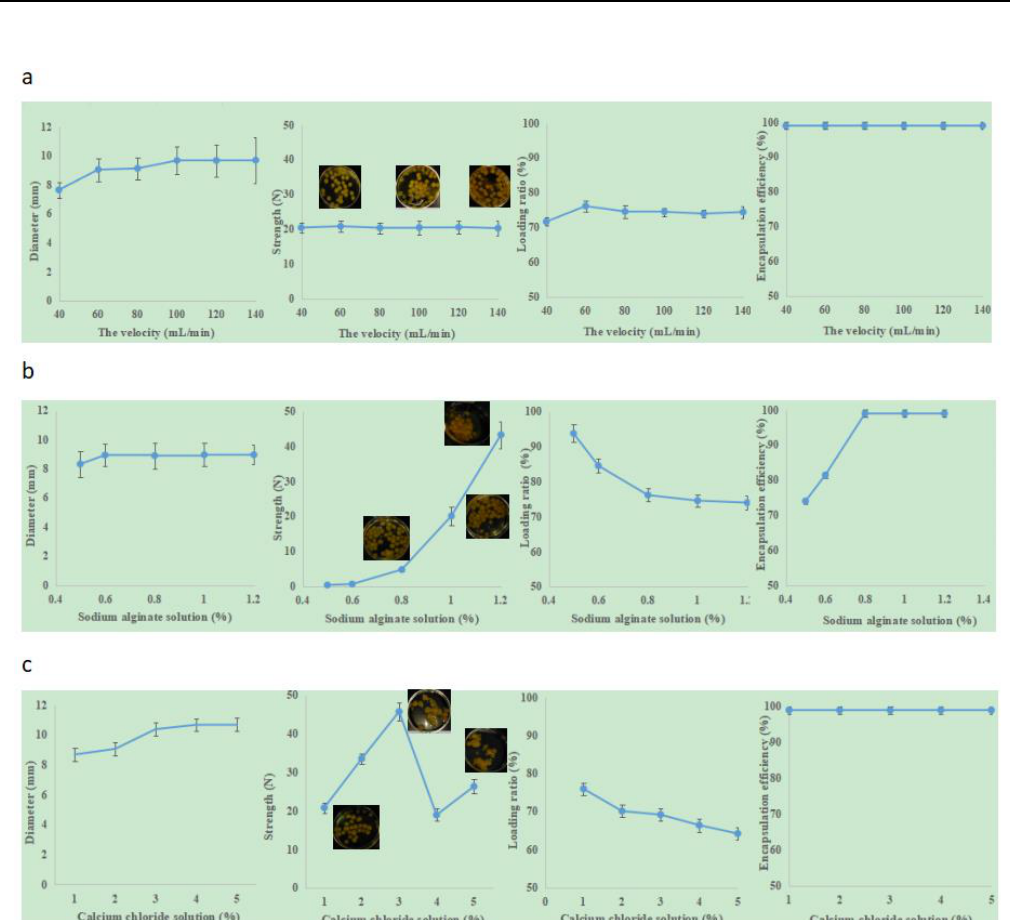
Figure 3. Effects of the preparation situation on the characteristics of the “boba” balls. ( a ) Flow velocity; ( b ) Sodium alginate solution concentration; ( c ) Calcium chloride solution concentration.